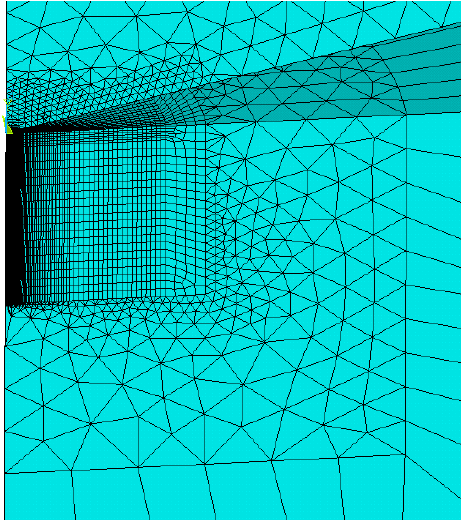
Figure 4. The mesh in the area near